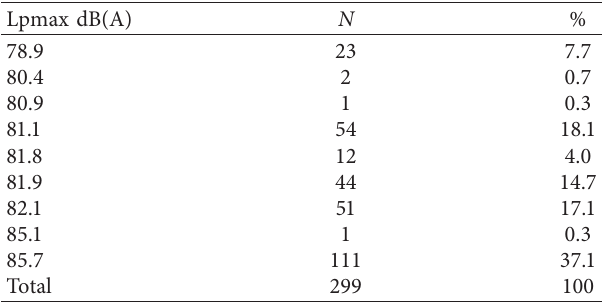
Figure 2: Sound level Lp south of the practical classroom. Table 1: Maximum sound level Lpmax south of the practical room.